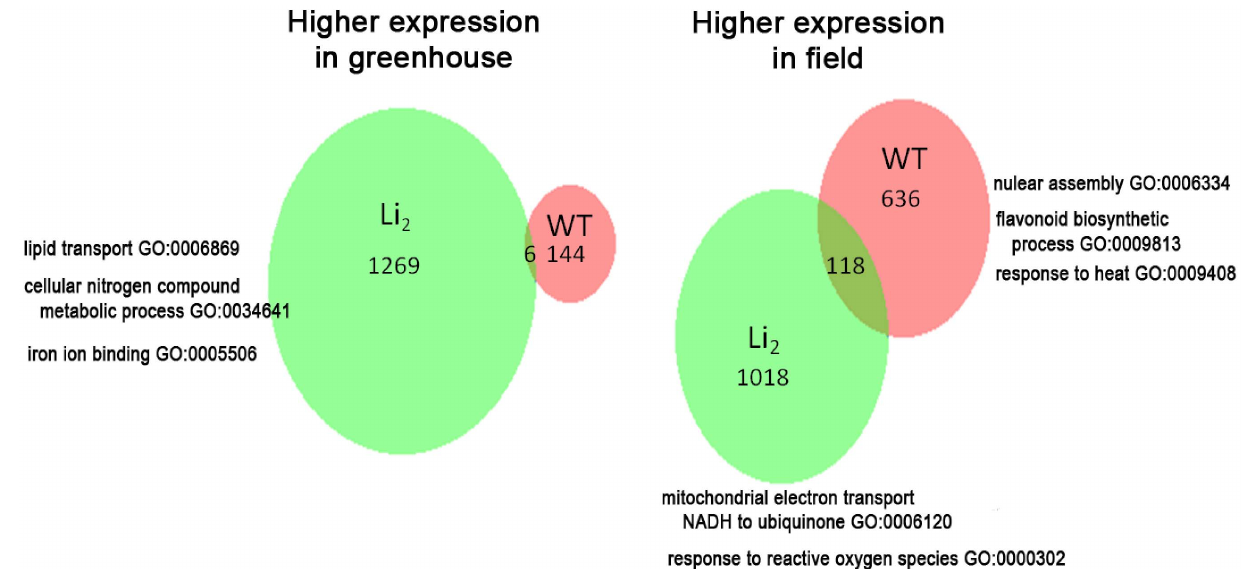
Figure 2. Probes showing altered regulation between greenhouse and field grown cotton. Each number represents the number of probes that showed altered expression between field and greenhouse conditions. Samples shown are 12 days post anthesis fibers. The included